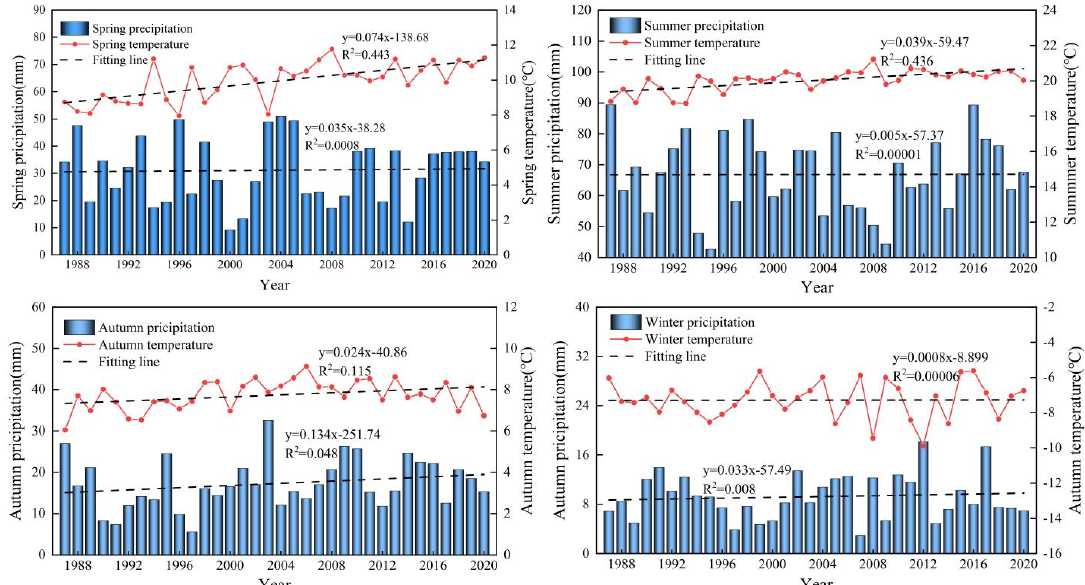
Figure 2. Temporal characteristics of seasonal climate change in the Tarim Basin. Panels show the climate change in spring, summer, autumn, and winter, respectively.